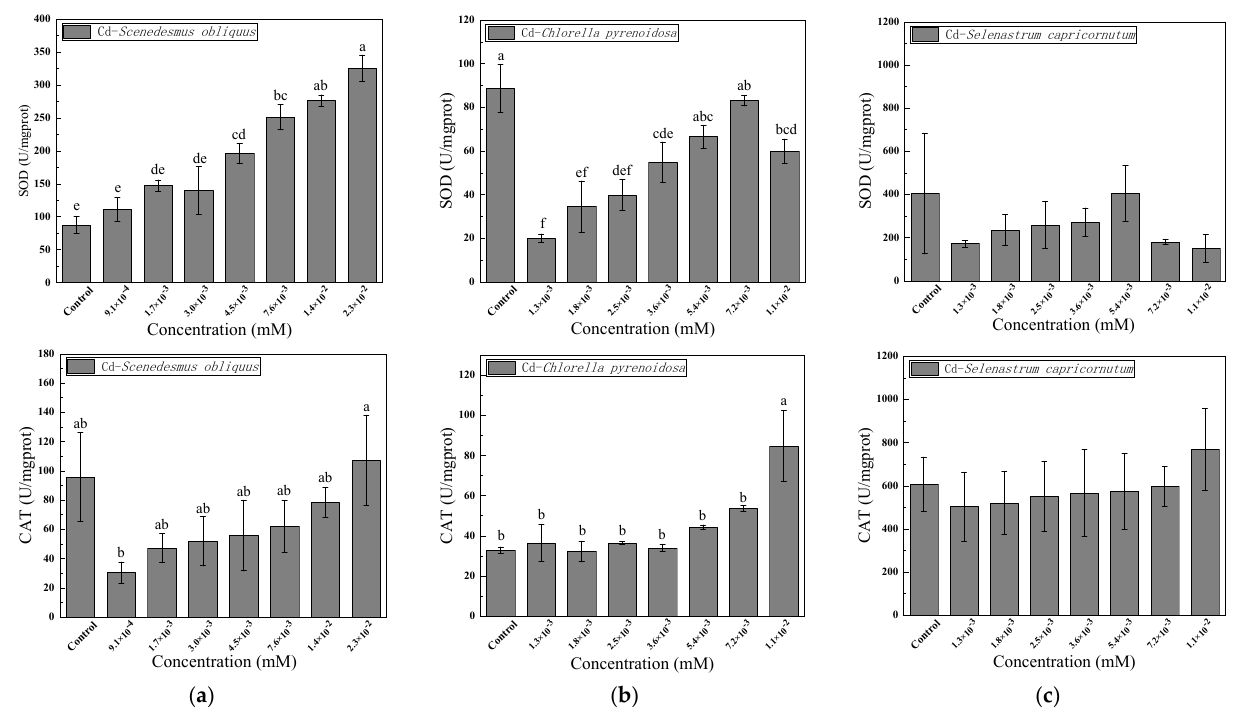
Figure 3. Effects of 96-h Cd exposure on the activity of superoxide dismutase (SOD) and catalase (CAT) in S. obliquus ( a ), C. pyrenoidosa ( b ), and S. capricornutum ( c ). The different letters: a, b, c, d, e, and f in the figure indicated that significant differences ( p < 0.05).